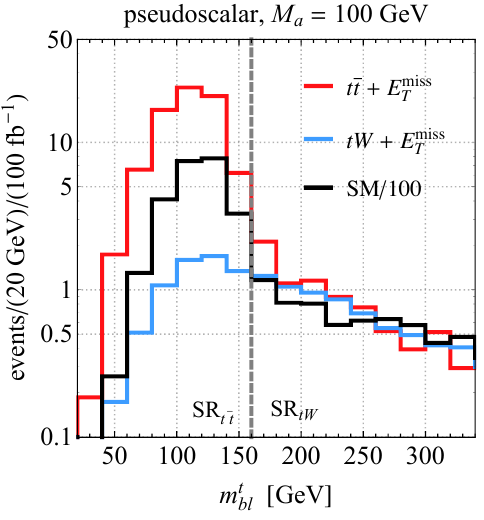
Figure 5 . Distributions of the m t variable (6.1) for the t (cid:22) t + E miss signal, the tW + E miss signal, and T T bl the sum of SM backgrounds scaled down by a factor 100. The shown results correspond to 100 fb (cid:0) 1 of 14 TeV LHC data and the common lepton, b -jet and m T 2 selections summarised in table 1. The used model parameters are m (cid:31) = 1 GeV, g (cid:31) = g t = 1 and those appearing in the headline of the (cid:12)gure. The dashed line corresponds to m t = 160 GeV, which represents the boundary between the bl two signal regions SR and SR tW t (cid:22) t